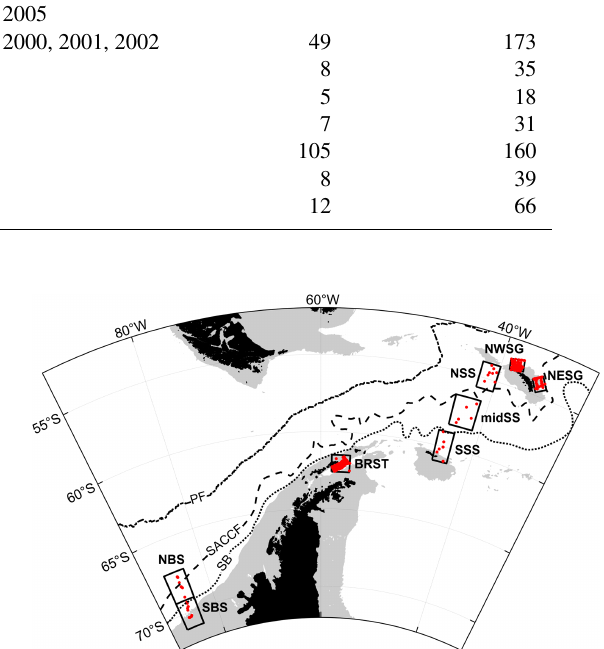
Figure 7. Areas sub-sampled to illustrate regional variation: NWSG: north-western South Georgia; NESG: north-eastern South Georgia; NSS: northern Scotia Sea; midSS: mid-Scotia Sea; SSS: southern Scotia Sea; BRST: Bransfield Strait; NBS: northern Bellingshausen Sea; SBS: southern Bellingshausen Sea. Red dots mark sample locations included in the analyses. Southern Ocean fronts and bathymetry are shown as in Fig.